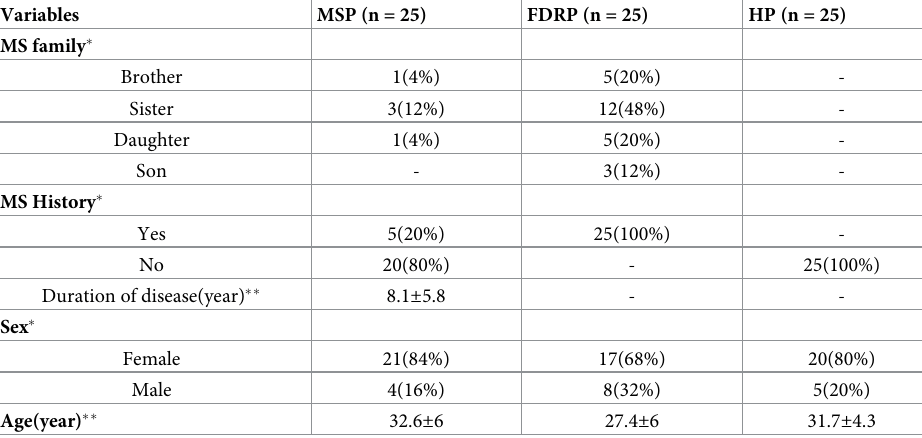
Table 1. Demographic and disease characteristics. Variables MSP (n = 25) FDRP (n = 25) HP (n = 25) MS family � Brother 1(4%) 5(20%) - Sister 3(12%) 12(48%) - Daughter 1(4%) 5(20%) - Son - 3(12%) - MS History � Yes 5(20%) 25(100%) - No 20(80%) - 25(100%) Duration of disease(year) �� 8.1 ± 5.8 - - Sex � Female 21(84%) 17(68%) 20(80%) Male 4(16%) 8(32%) 5(20%) Age(year) �� 32.6 ± 6 27.4 ± 6 31.7 ± 4.3 The data are presented as frequency (percent) for categorical � variables and as mean ± SD for numeric normal �� variables. Abbreviation: MSP, Multiple Sclerosis Participants; FDRP, First-Degree Relative Participants; HP,